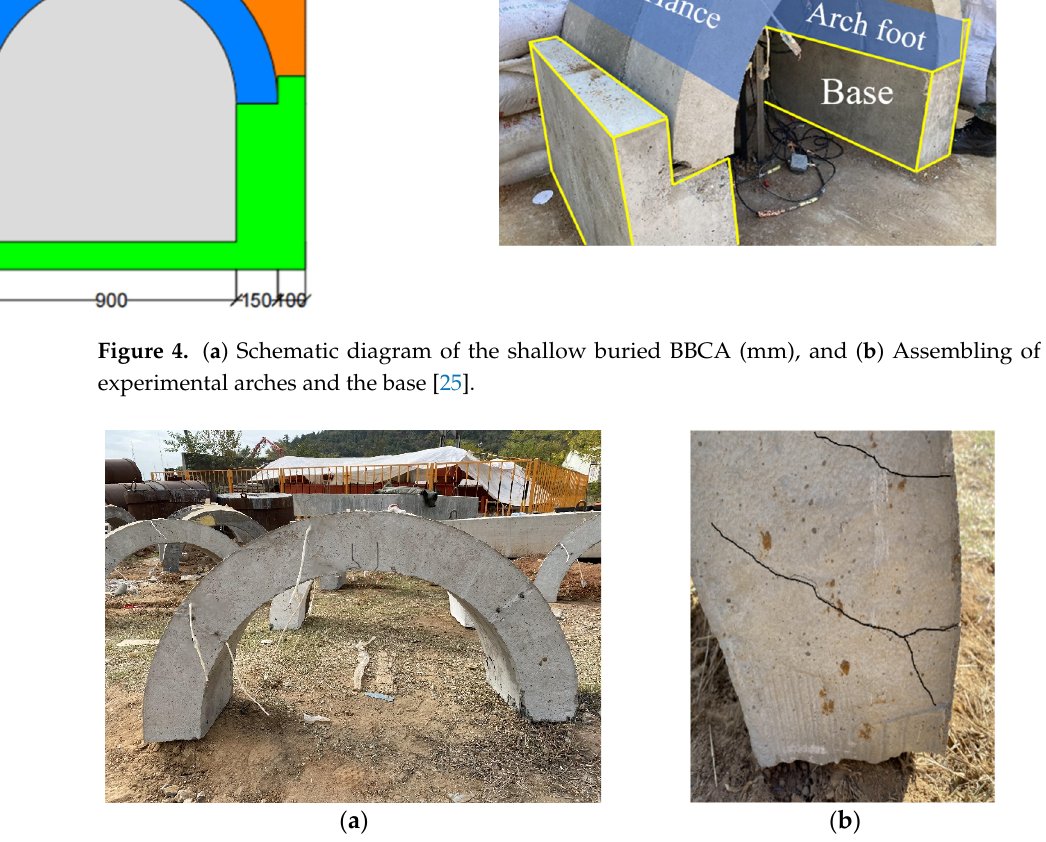
Figure 5. Macroscopic damage to the blast-loaded arches: ( a ) two cracks of the inner side of the vault, and ( b ) shear cracks at arch foot.